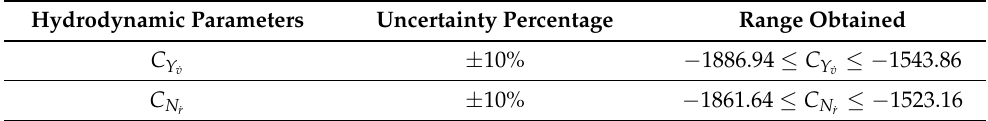
and C N in vertical ˙ r ˙ v